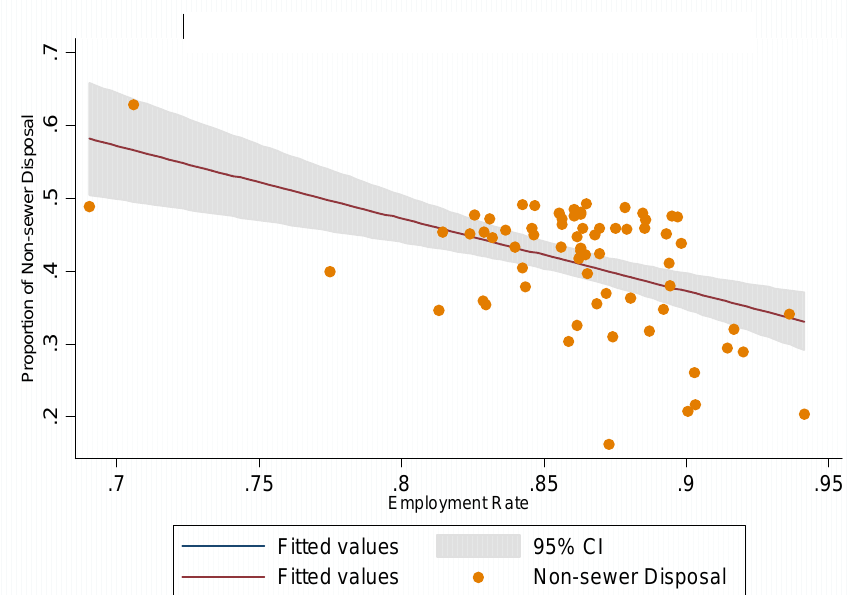
Figure 3. Variation of employment rate with non-sewer disposal rate. Figure 3: Variation of employment rate with non-sewer disposal